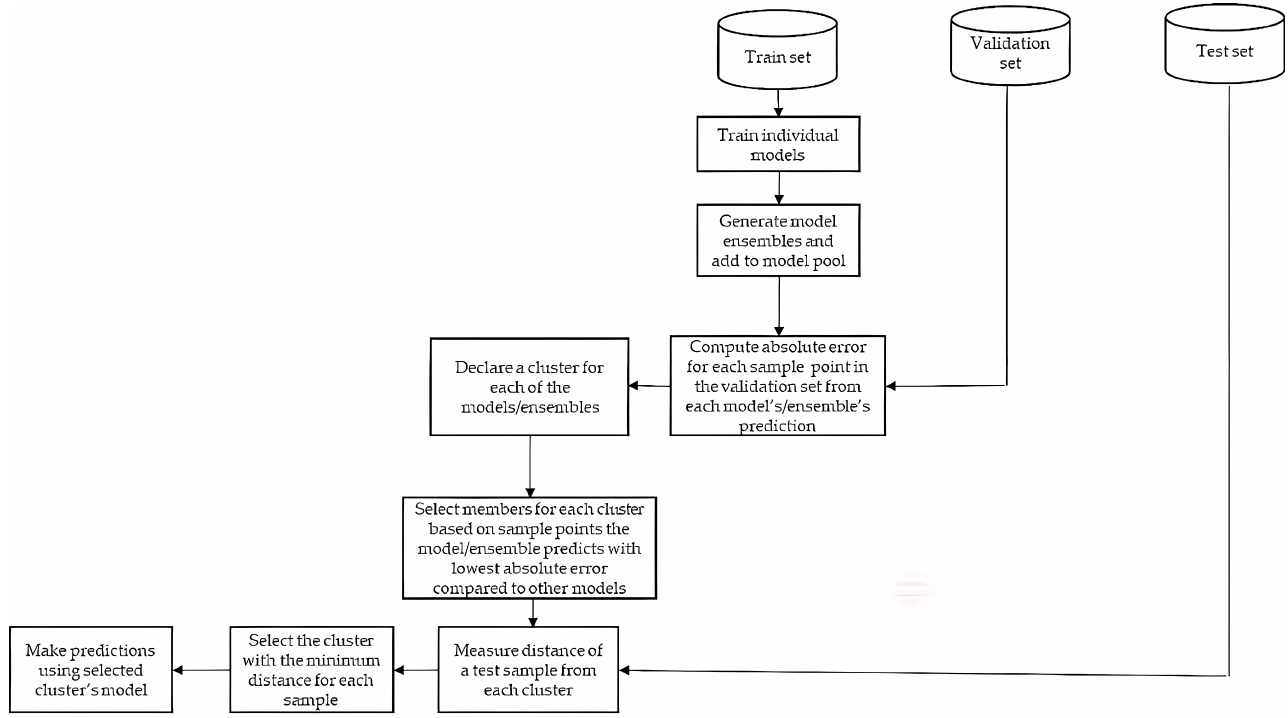
Figure 2. Dynamic Ensemble selection